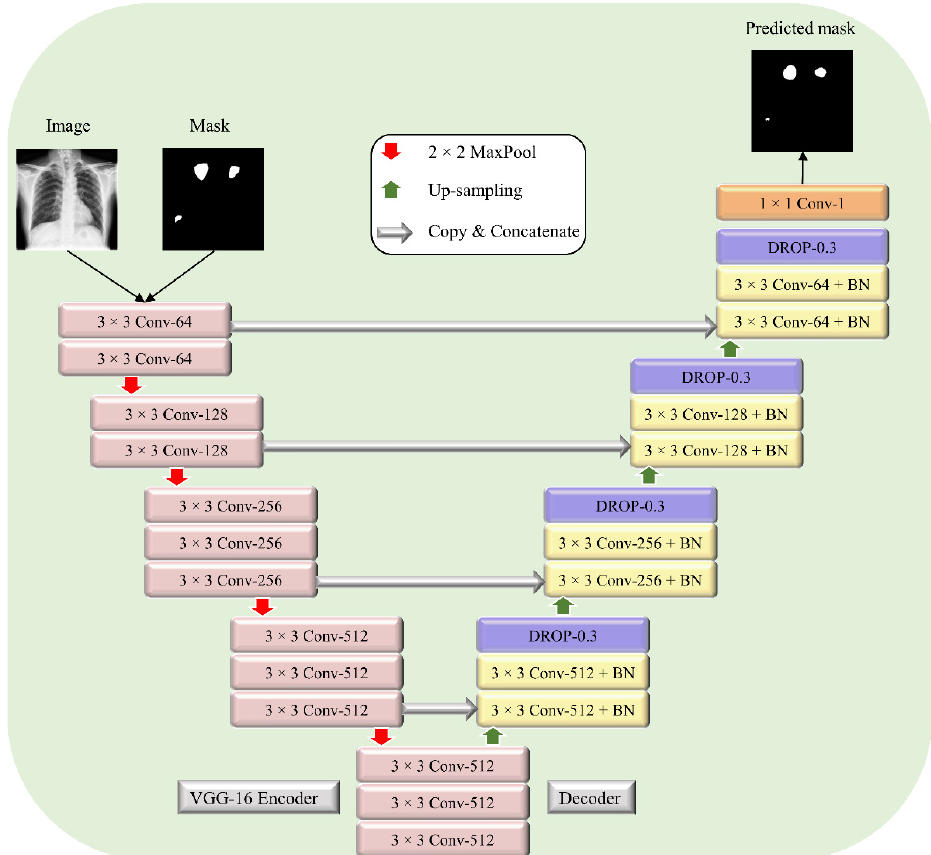
Figure 2. The architecture of the proposed VGG-16-based U-Net model. The encoder is a VGG-16 model initialized with ImageNet weights.